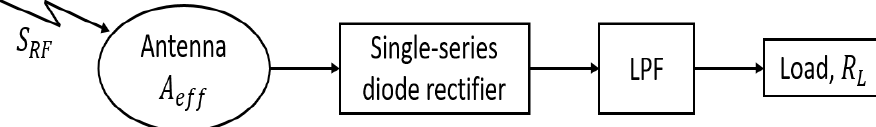
Figure 1. Block diagram of the wireless energy harvesting system. A plane wave received by the antenna element has power density S RF . Subsequent stages are the rectifier circuit, low-pass filter (LPF), and the load that consumes the DC